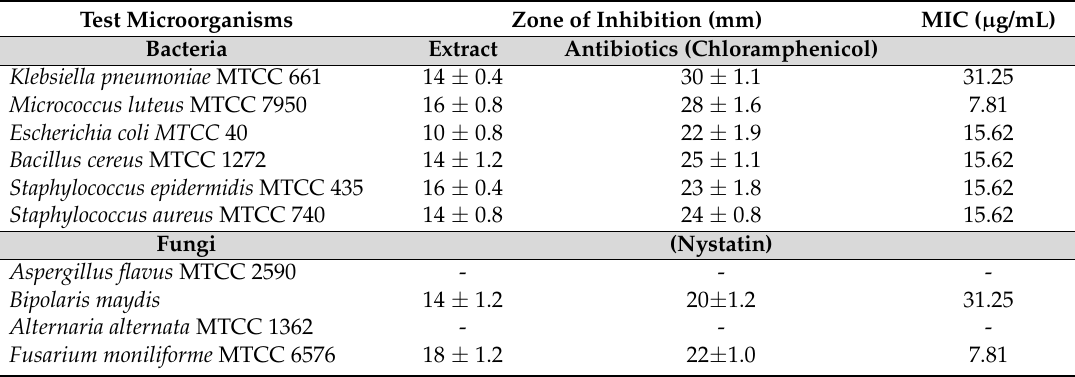
Table 1. Antimicrobial activity and MIC ( µ g/mL) of Streptomyces sp.S2A by broth dilution method. Test